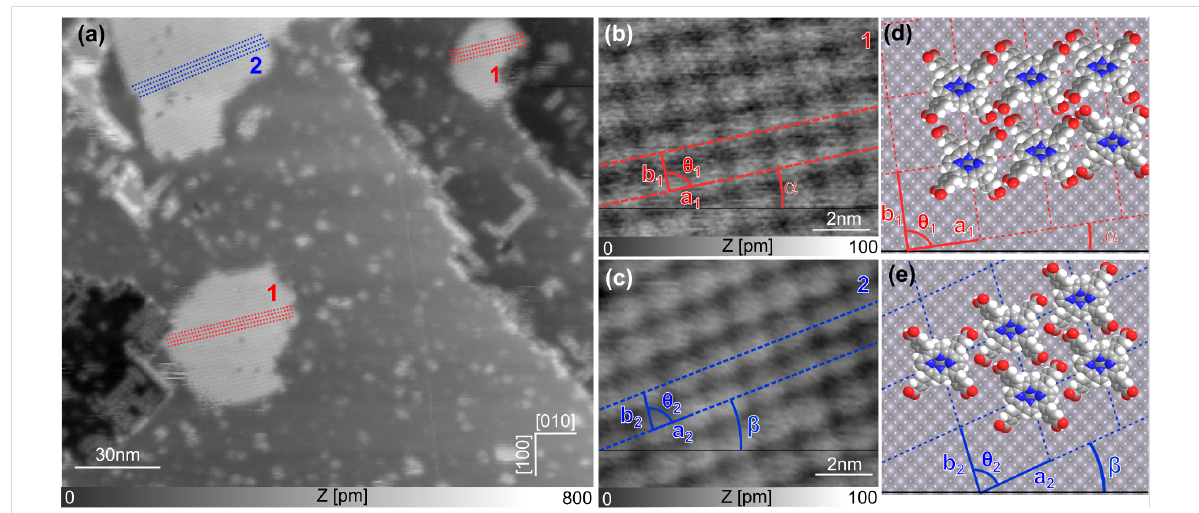
Figure 3: (a) Large-scale topographic image showing that Cu-TCPP molecules form islands on the surface of NiO(001) (scan parameters: = 7 nm, Δ f 1 = − 7 Hz). (b, c) Close-up topographic images recorded on a type-1 and a type-2 island, respectively (scan parameters: = 4 nm, Δ f 1 = − 38 Hz and = 7 nm, Δ f 1 = − 8 Hz); (d, e) Models corresponding to (b) and